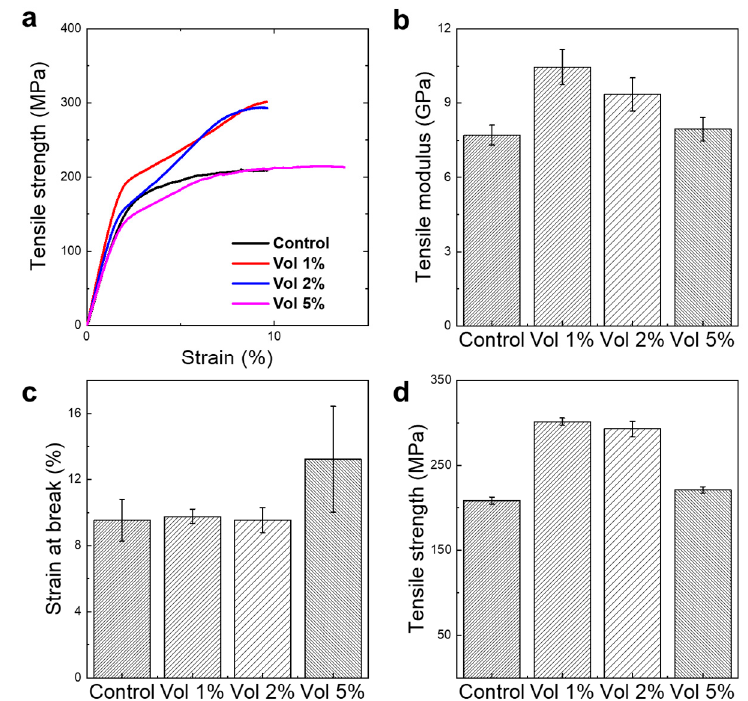
Figure 6. The mechanical properties of regenerated silk fibroin fiber reinforced by LCNC as a function of volume fraction. Different amounts of CNC affects tensile modulus, strain at break, and tensile strength. ( a ) Characteristic stress-strain curves, ( b ) Bar diagram of tensile modulus, ( c ) Bar diagram of strain at break, and ( d ) Bar diagram of tensile strength.